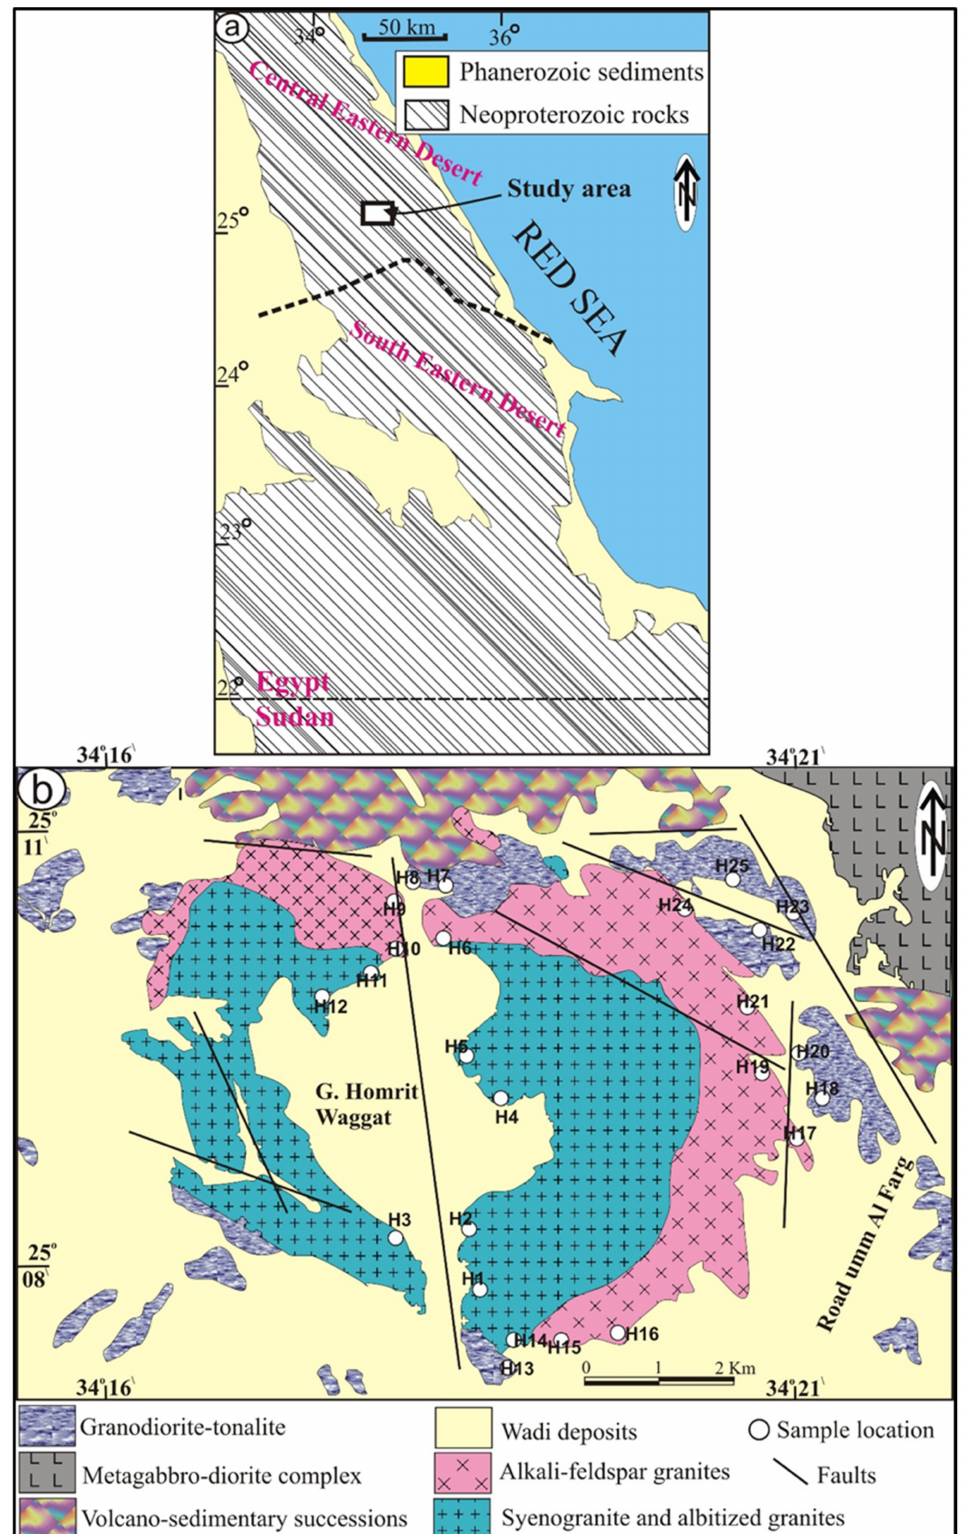
Figure 1. ( a ) Location map of Homrit Waggat area, Central Eastern Desert of Egypt; ( b ) geologic map of Homrit Waggat area with sample locations modified after